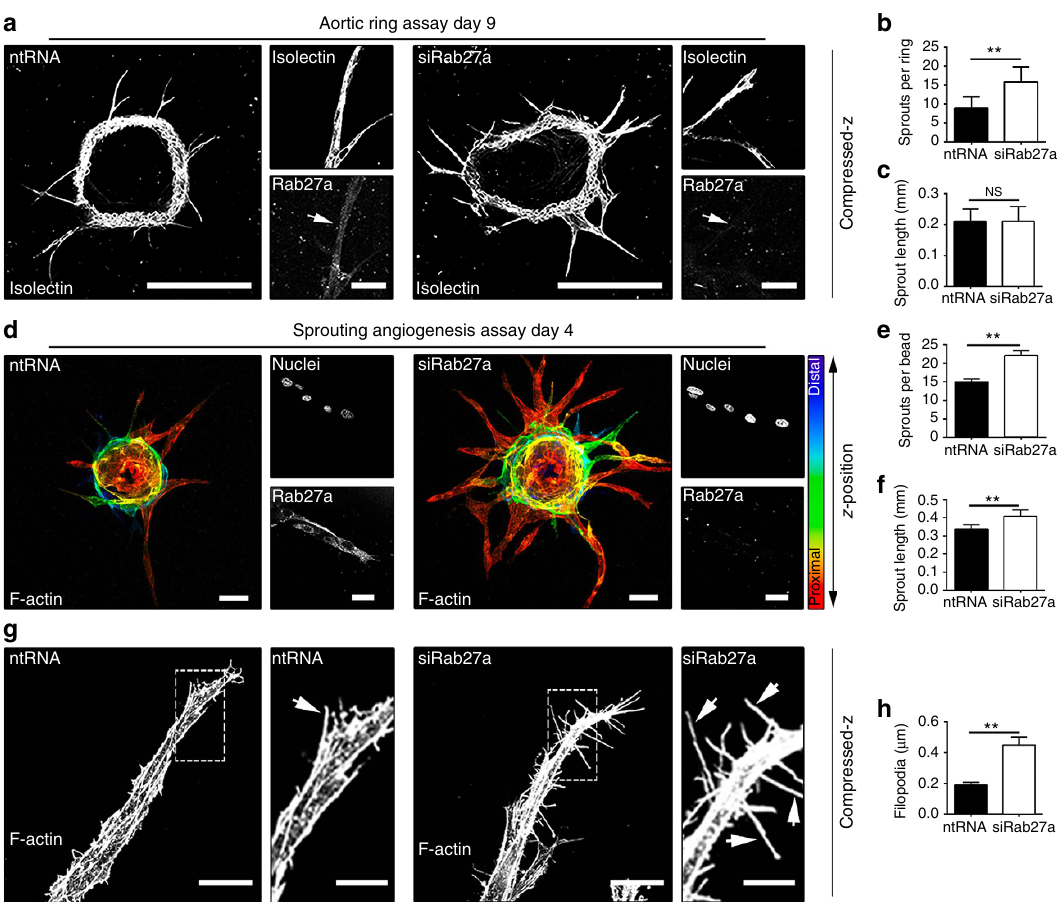
Figure 6 | Rab27a regulates vascular sprouting. ( a – c ) ( a ) Aortic rings with indicated siRNAs. Small boxes, indicated stainings, scale bars: 500 and 25 m m for large and small boxes, respectively. ( b , c ) Quantification of angiogenic parameters after indicated treatments. (No. of rings, ntRNA ¼ 14; siRab27a ¼ 12); three replicates. ( d – f ) ( d ) HUVEC angiogenic sprouts with indicated treatments. Small boxes, indicated stainings, scale bars 50 and 25 m m for large and small boxes, respectively. ( e , f ) Quantification of angiogenic parameters. (sprouts per bead: ntRNA ¼ 12; siRab27a ¼ 14; sprout length: ntRNA ¼ 30; siRab27a ¼ 30); five replicates. ( g , h ) ( g ) Morphological analysis of HUVEC derived-sprouts with indicated treatments, scale bars: 25 and 10 m m, for large and small boxes, respectively. ( h ) Quantification of filopodia per m m of vessels. Arrows, filopodia. (ntRNA ¼ 10; siRab27a ¼ 14); five replicates. Statistics: Shown are means þ 95% CI. ( b , c , e , f , h ) Student’s t -test. ** P r 0.01; NS, not